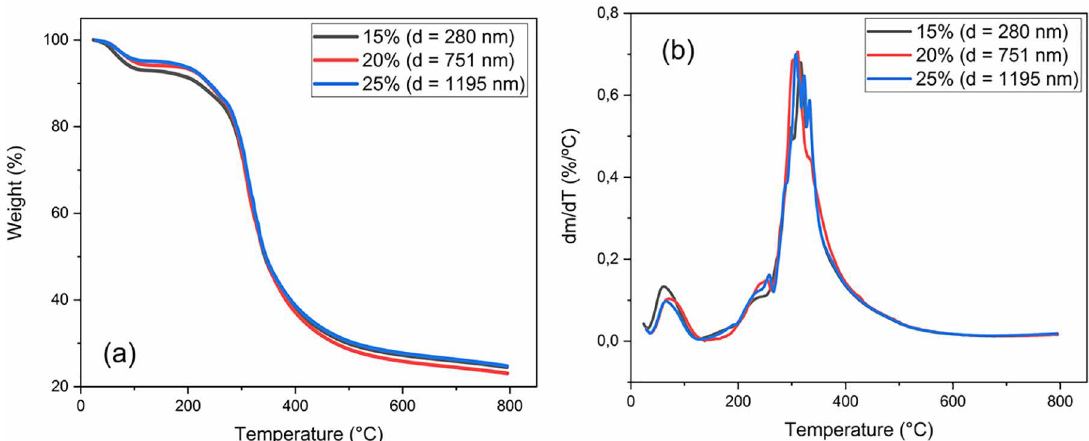
Figure 2. (a)TG and (b) DTG thermograms of microfibrous mat of fish